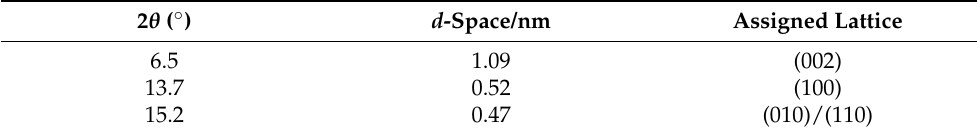
Figure 3. 1D-integrated WAXD profiles of PAPACM12 during isothermal crystallization process under 190 °C. Table 3. The position of the diffraction peak and corresponding d -space in 1D WAXD curves at 190 °C for 60 min.